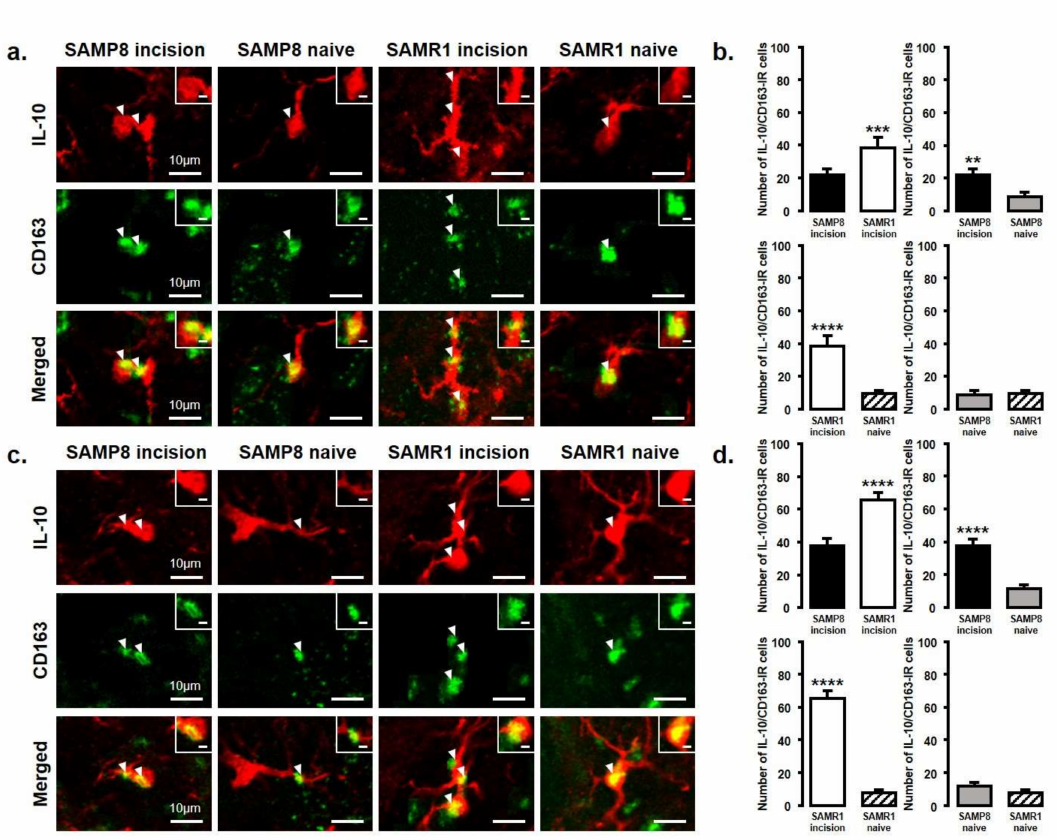
Figure 6. IL-10 released from M2 phenotype microglia in the Vc and C1 / C2 regions on day 3 and day 11 after palatal mucosal incision. ( a ) Low and high (inset) magnification photomicrographs of IL-10-IR cells (red), CD163-IR cells (green), and IL-10-IR / CD163-IR cells in the Vc and C1 / C2 regions on day 3 after palatal mucosal incision in SAMP8 and SAMR1 mice. The arrowheads indicate IL-10-IR / CD163-IR cells. Scale bar: 10 µ m. Scale bar in the inset: 3 µ m. ( b ) The number of IL-10-IR / CD163-IR cells in the medulla on day 3 after palatal mucosal incision in SAMP8 and SAMR1 mice. Data represent mean ± SD ( n = 4 for SAMP8 incision mice, SAMR1 incision mice, SAMR1 naive mice, and SAMP8 naive mice. ** p < 0.01, *** p < 0.001, **** p < 0.0001, Student’s t -test). ( c ) Low and high (inset) magnification photomicrographs of IL-10-IR cells (red), CD163-IR cells (green), and IL-10-IR / CD163-IR cells in the Vc and C1 / C2 regions on day 11 after palatal mucosal incision in SAMP8 and SAMR1 mice. The arrowheads indicate IL-10-IR / CD163-IR cells. Scale bar: 10 µ m. Scale bar in the inset: 3 µ m. ( d ) The number of IL-10-IR / CD163-IR cells in the medulla on day 11 after palatal mucosal incision in SAMP8 and SAMR1 mice. Data represent mean ± SD ( n = 4 for SAMP8 incision mice, SAMR1 incision mice, SAMR1 naive mice, and SAMP8 naive mice. **** p < 0.0001, Student’s t -test). The number of IL-10-IR / CD163-IR cells was significantly increased in both SAMP8 and SAMR1 mice on days 3 and 11 after incision. Comparing SAMP8 with SAMR1 incision mice, the SAMR1 incision mice showed a significantly higher number of IL-10-IR / CD163-IR cells than the SAMP8 incision mice on days 3 and 11 (day 3, SAMP8 incision mice: 22 ± 3.6; SAMR1 incision mice: 38.3 ± 6.5;